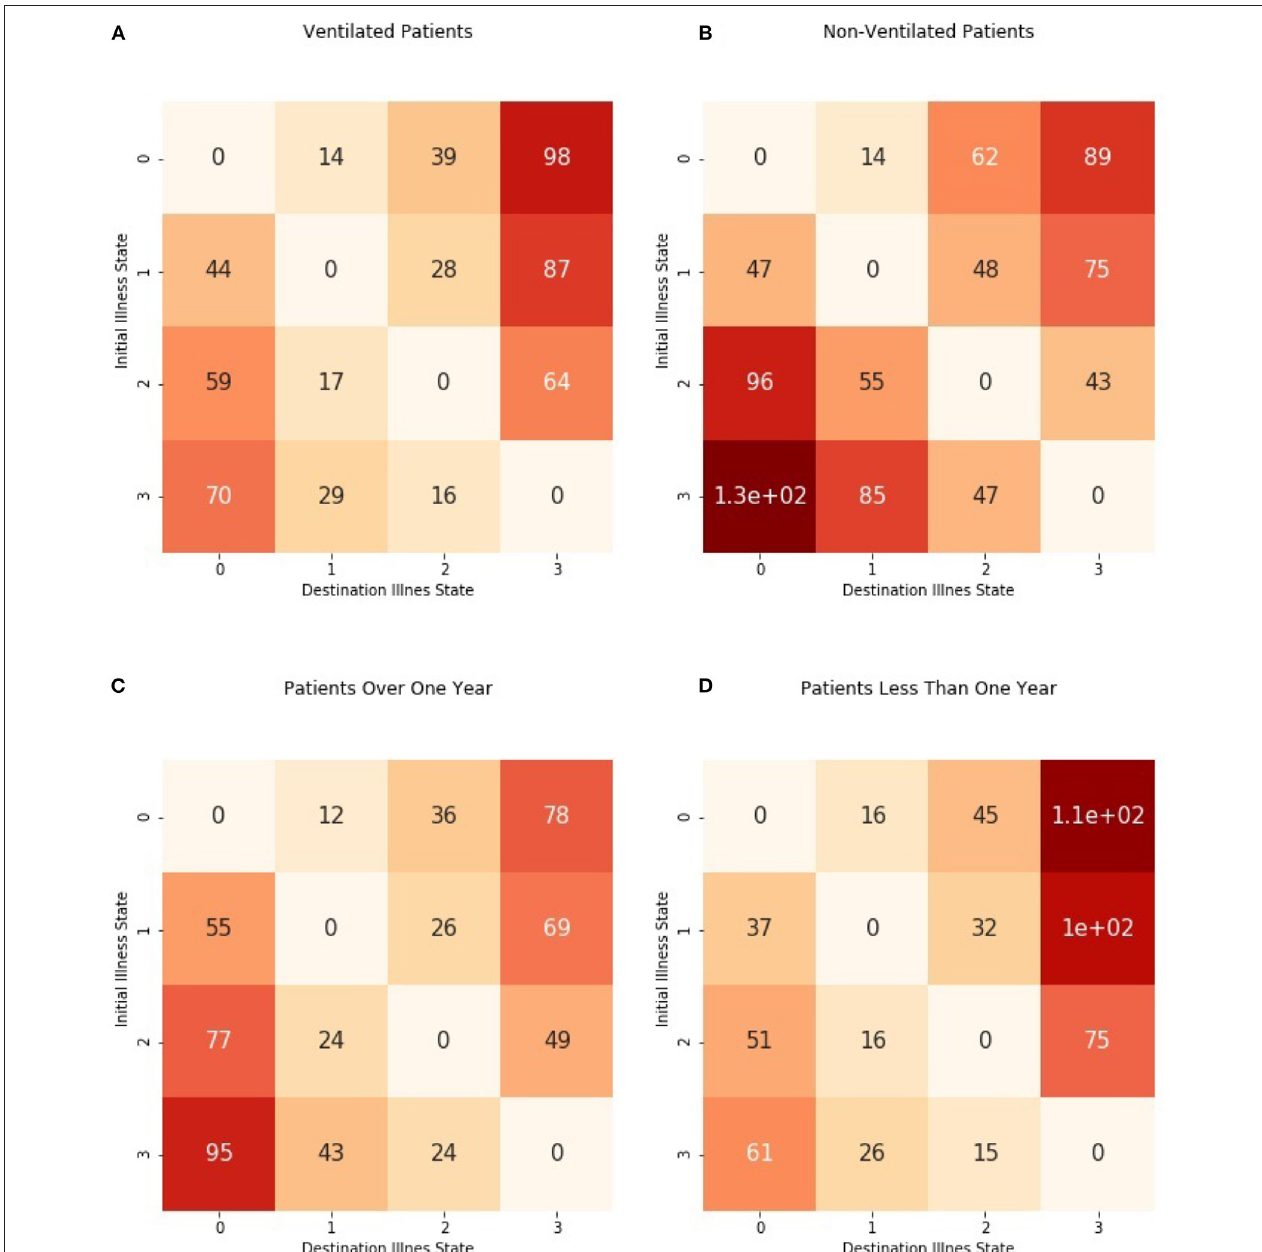
FIGURE 6 | Mean first passage times from initial illness states to destination illness states stratified by ventilator use and age group. Times were estimated separately for (A) patients requiring mechanical ventilation and (B) patients without mechanical ventilation as well as (C) patients older than 1 year and (D) patients from birth to 1